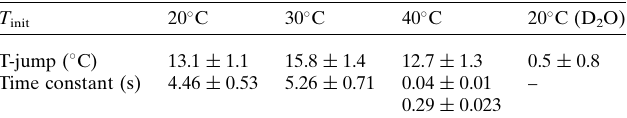
Table 1 Derived parameters for the different lysozyme measurements in an H 2 O buffer solution (except where indicated).